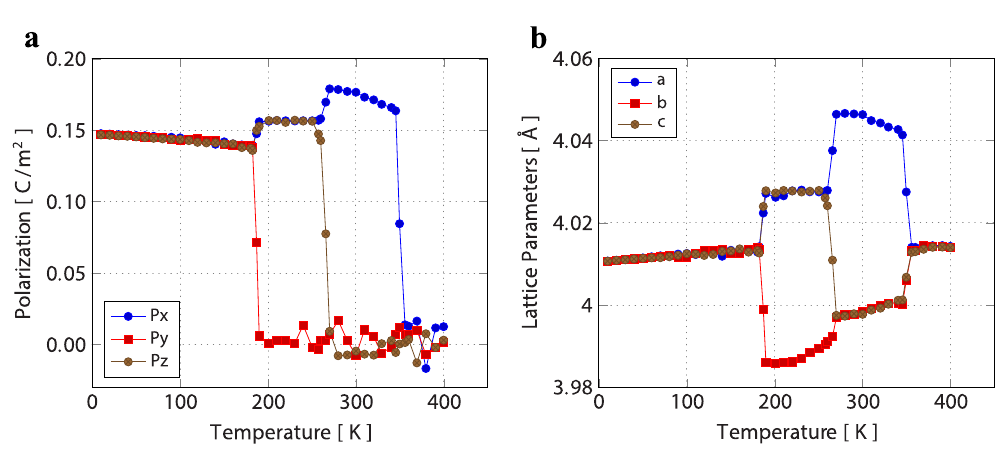
Figure 10. Phase transition sequence and temperatures for BaTiO 3 . ( a ) Average lattice constants and ( b ), average polarisation along the the three lattice directions as function of temperature. Core-shell molecular dynamics is performed with a system of periodic 10 × 10 × 10 unit cells 28